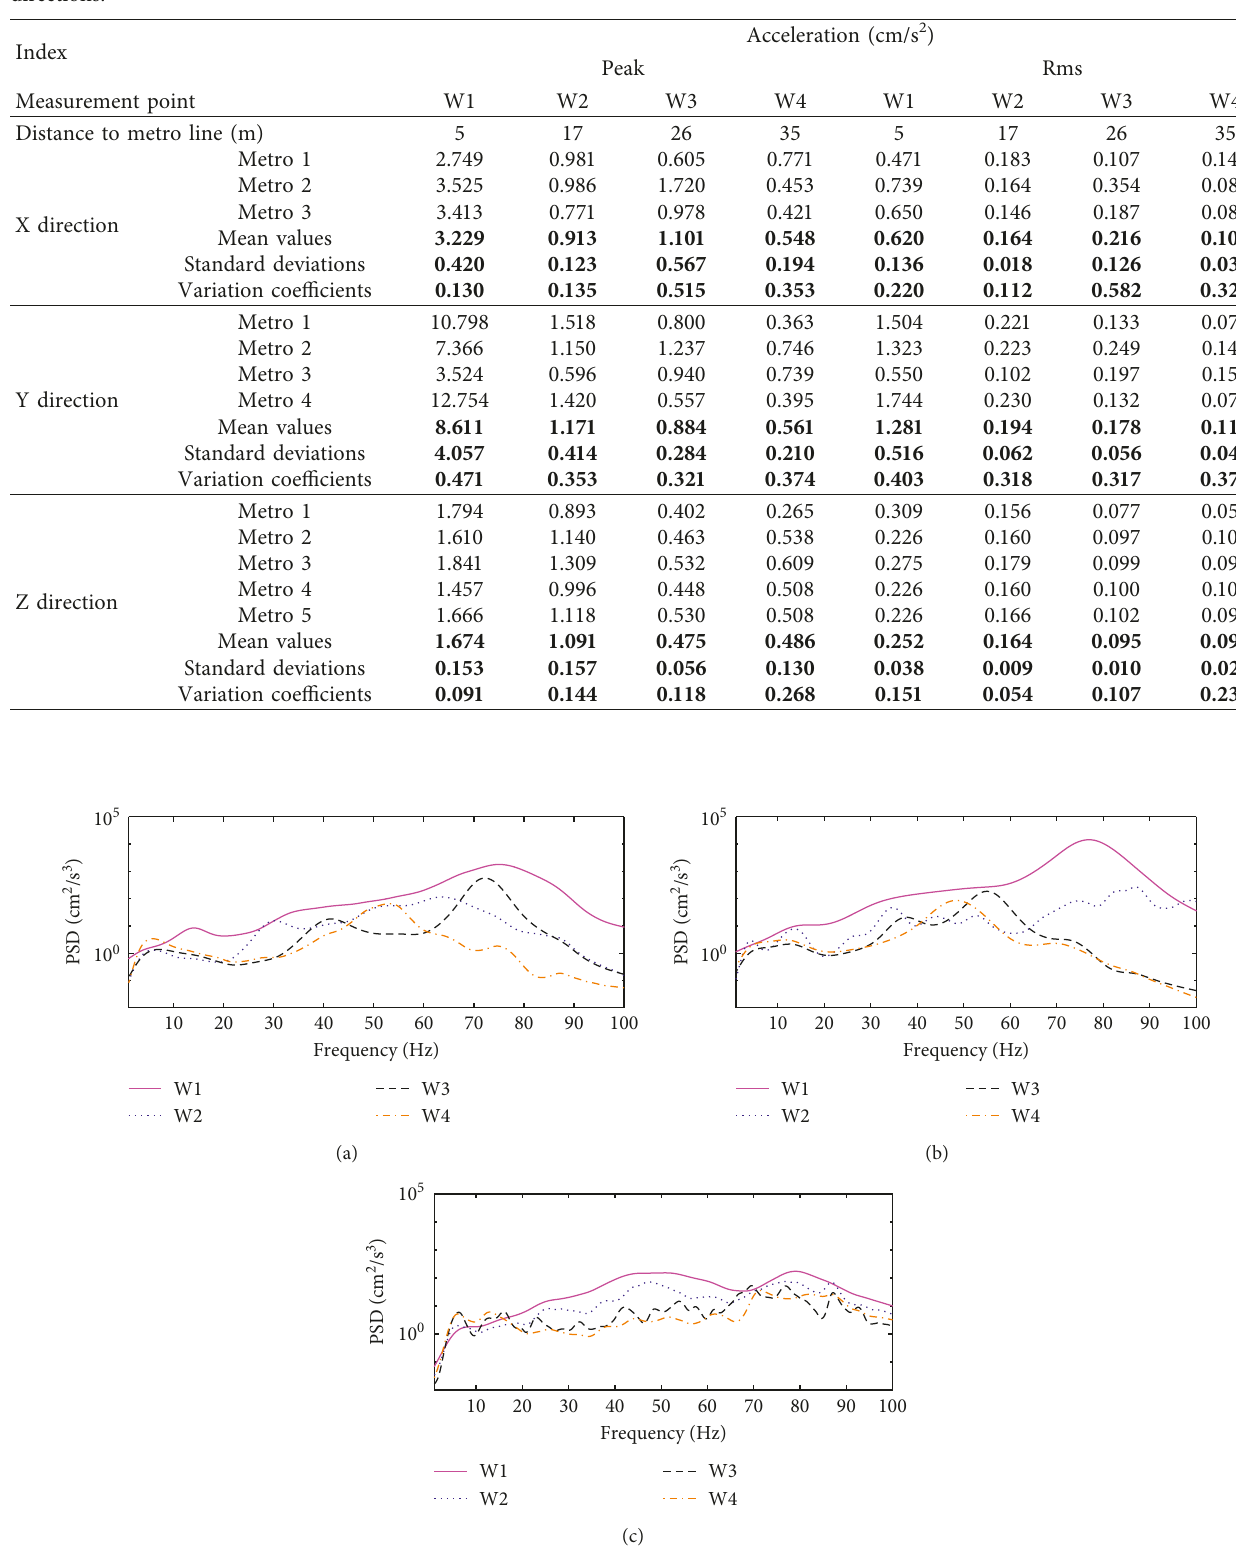
Figure 9: The smoothed average acceleration PSDs of subway-induced vibration on free field. (a) X direction. (b) Y direction. (c) Z